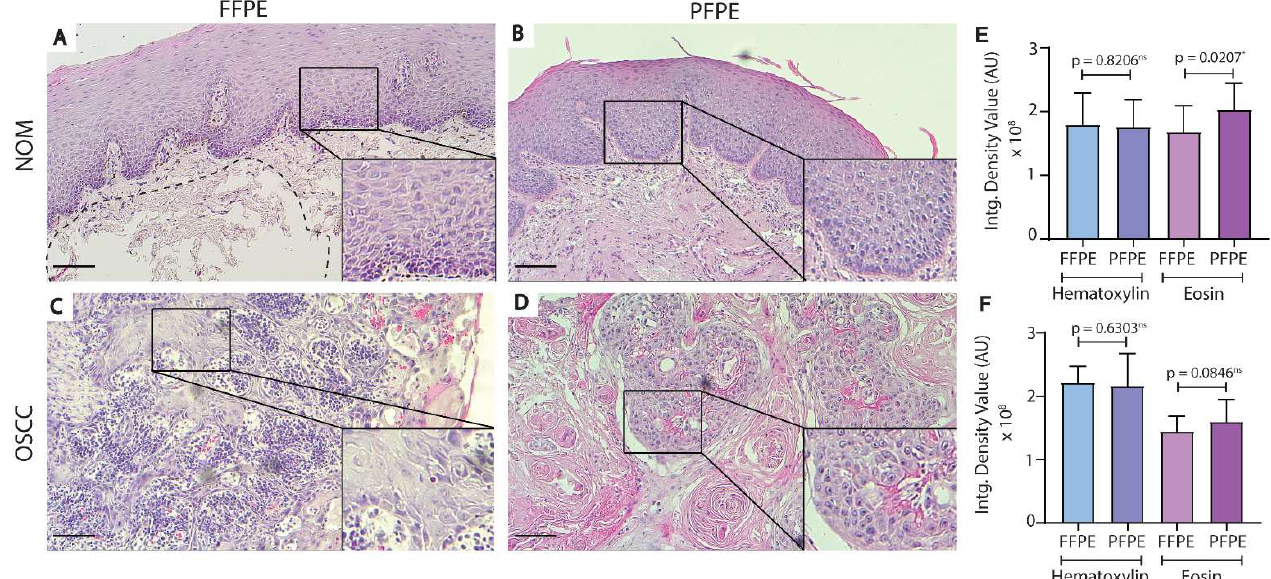
Figure 2. Morphological comparisons of PFPE and FFPE tissues. Hematoxylin and eosin staining was performed on FFPE NOM and OSCC tissues ( A , C ) and PFPE NOM and OSCC tissues ( B , D ). PFPE tissues were more eosinophilic than FFPE tissues ( A , B )—corresponding integrated density value plot ( E )—and ( C , D )—corresponding integrated density value plot ( F ). Morphology of the epithelium layers and sub-epithelium region was well-preserved in PFPE-NOM tissue ( B ) and was comparable to FFPE-NOM tissue ( A ). Squamous cell carcinoma was well-represented in both PFPE ( C ) and FFPE tissue ( D ). High magnification insets for each panel ( A – D ) shows the morphology of the epithelial cells in NOM ( A , B ) and OSCC ( C , D ). An example of loss of tissue area (dotted lines) due to sample processing was shown in FFPE-NOM tissue ( A ). Magnification = 10×; Scale bar = 50 µm. p < 0.05 * (student’s t -test). Abbreviations: PFPE, PAXgene-fixed paraffin embed- ded; FFPE, formalin-fixed paraffin embedded; NOM, normal oral mucosa; OSCC, oral squamous cell carcinoma; Intg., integrated.